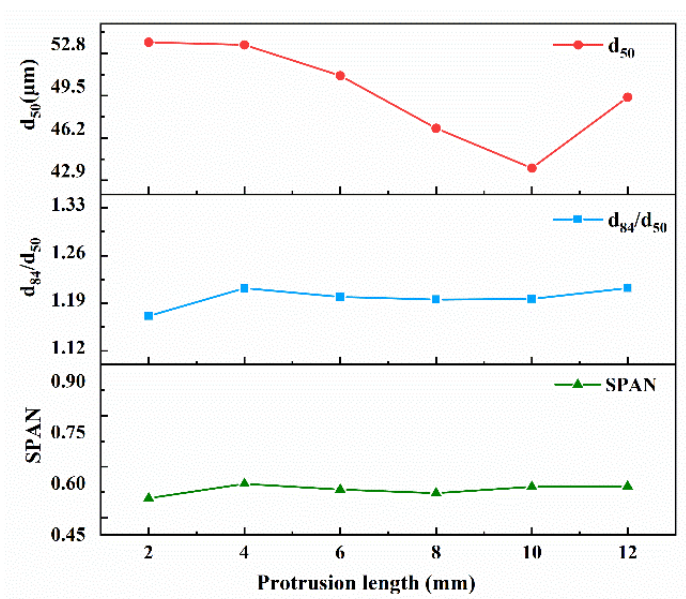
Figure 18. The e ff ect of melt tube protrusion length on d 50 , d 84 / d 50 and SPAN for the KHRT breakup Figure 18. The effect of melt tube protrusion length on d 50 , d 84 /d 50 and SPAN for the KHRT breakup model simulation. model simulation.